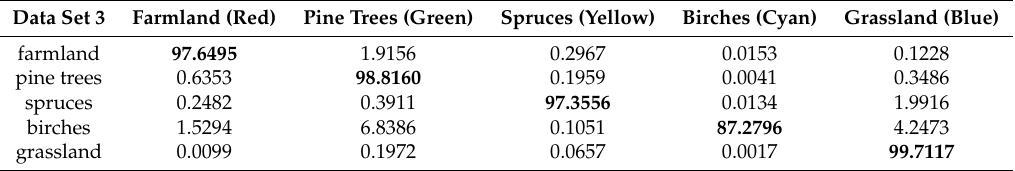
Table 4. Confusion matrix of the results achieved by the proposed method on the first date of data set 3. Data Set